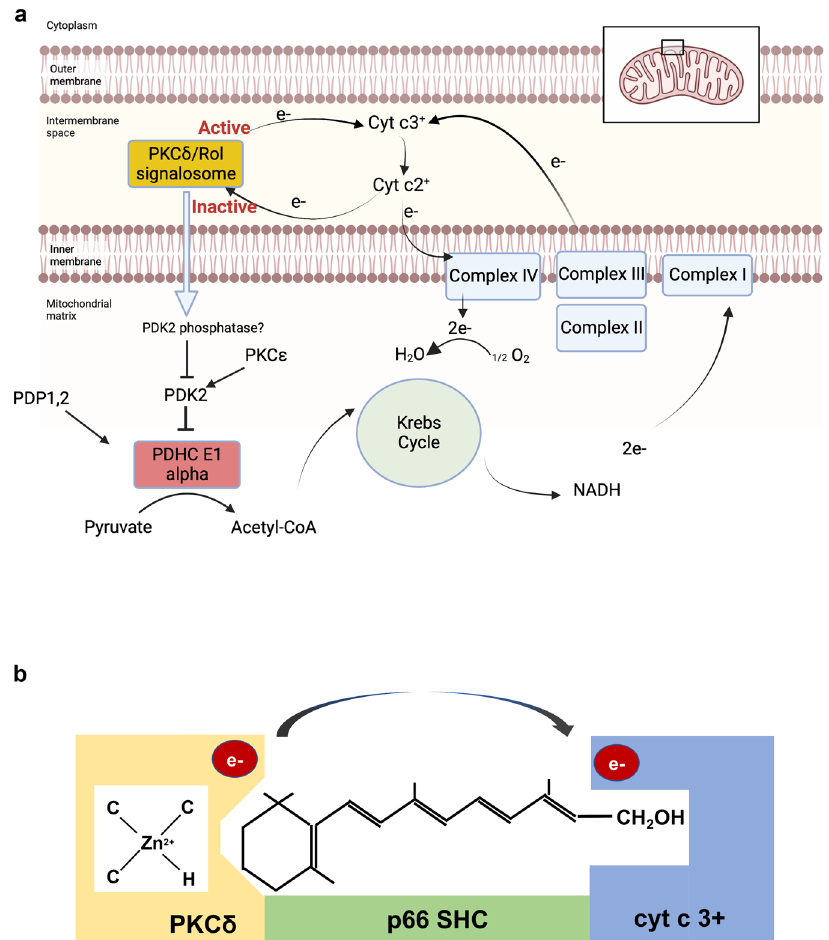
Fig. 1 Schematic of the PKC δ signalosome and its reversible redox regulation. a Reversible redox regulation of PKC δ . The PKC δ /Retinol (Rol) signalosome, located in the mitochondrial intermembrane space, comprises PKC δ , the signal adapter p66Shc, cytochrome c (cyt c) and all-trans retinol (See Fig. 1b). Activation of PKC δ is initiated by site-selective oxidation of speci fi c cysteines in its activation domain, a process involving the